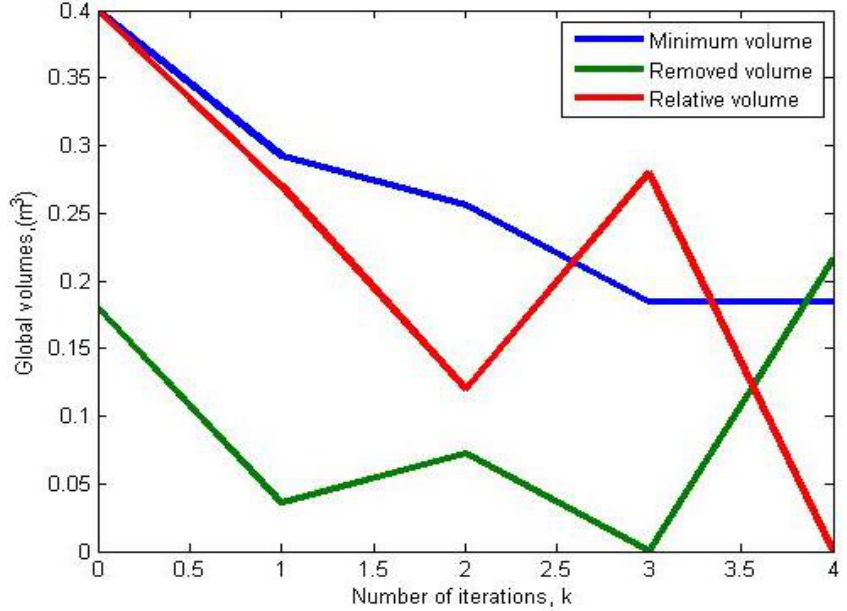
Figure 7. Volume reduction stopped automatically at the terminal iteration k=3